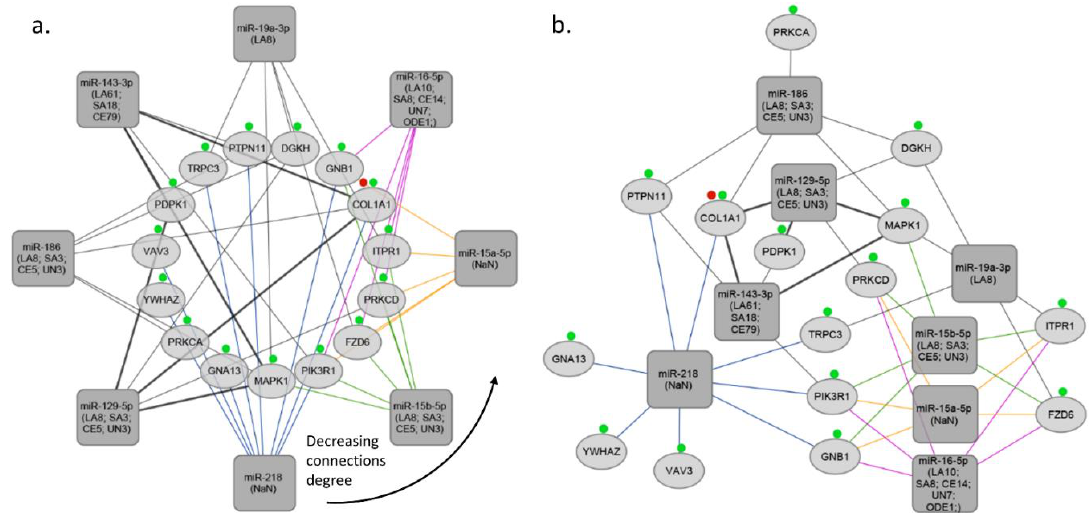
Figure 4. miRNA-target gene networks based on platelet activation. ( a ) Platelet activation-network sorted by the degree of connections, ( b ) Platelet activation-interaction network. The rectangles indicate the stroke type miRNAs, the ellipses indicate target genes. Red and green marks represent specific GO process-blood coagulation and platelet activation, respectively. LA, large artery stroke; SA, small artery stroke; UDN, stroke due to undetermined cause; CE, cardioembolic stroke; NaN, no data; ODE, other determined etiology; UN, determined cause.